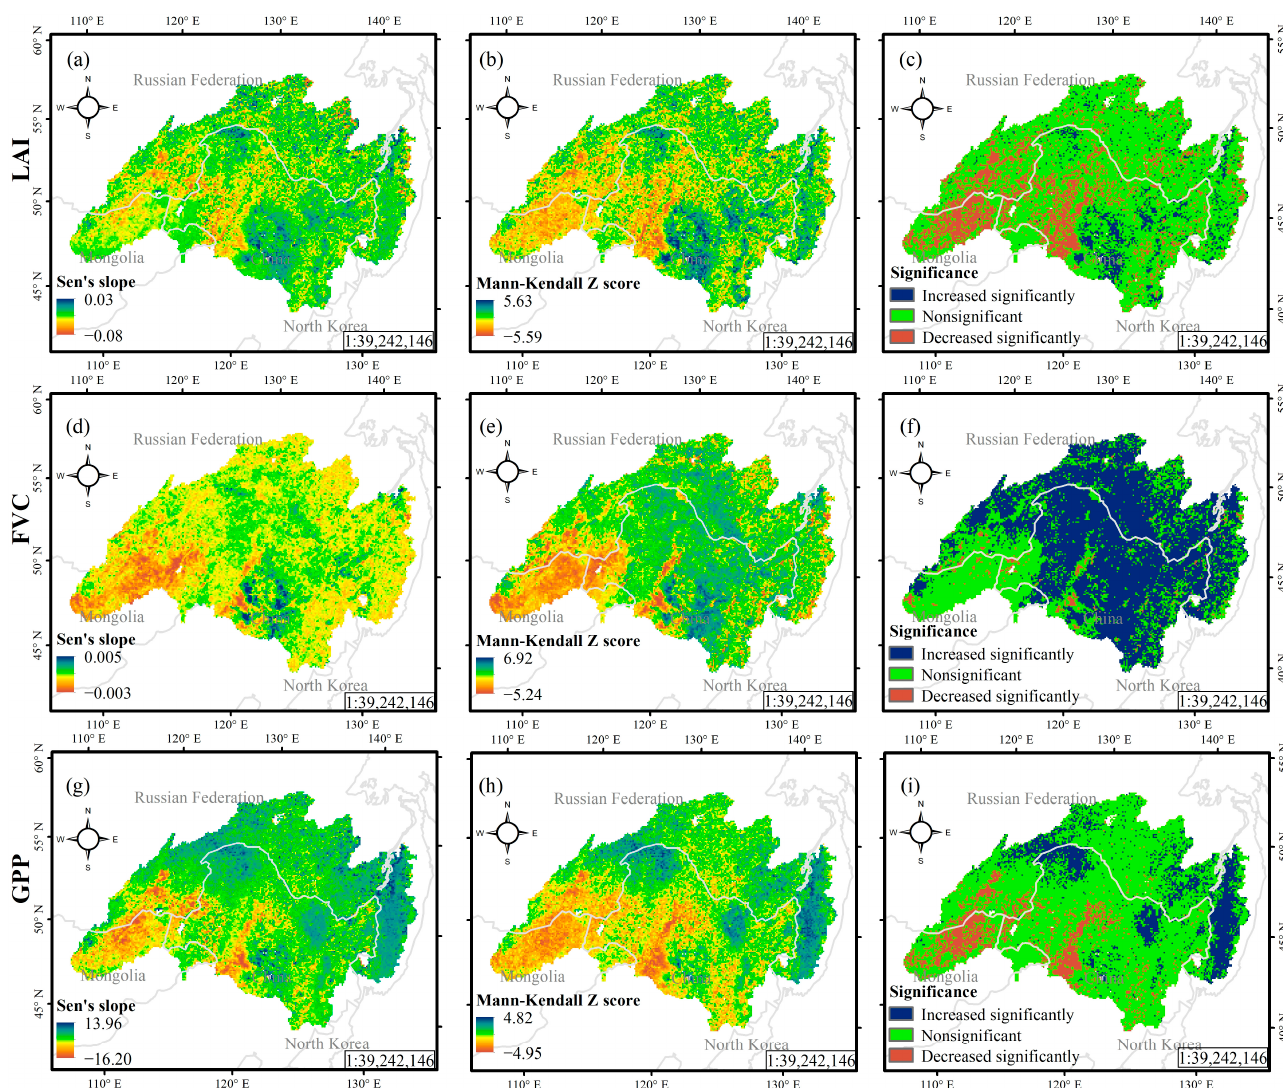
Figure 4. Spatial patterns of Sen’s slope, the Mann–Kendall Z score and the significance of changes for the annual LAI ( a – c ), FVC ( d – f ) and GPP ( g – i ) from 1982 to 2013 in the ARB.